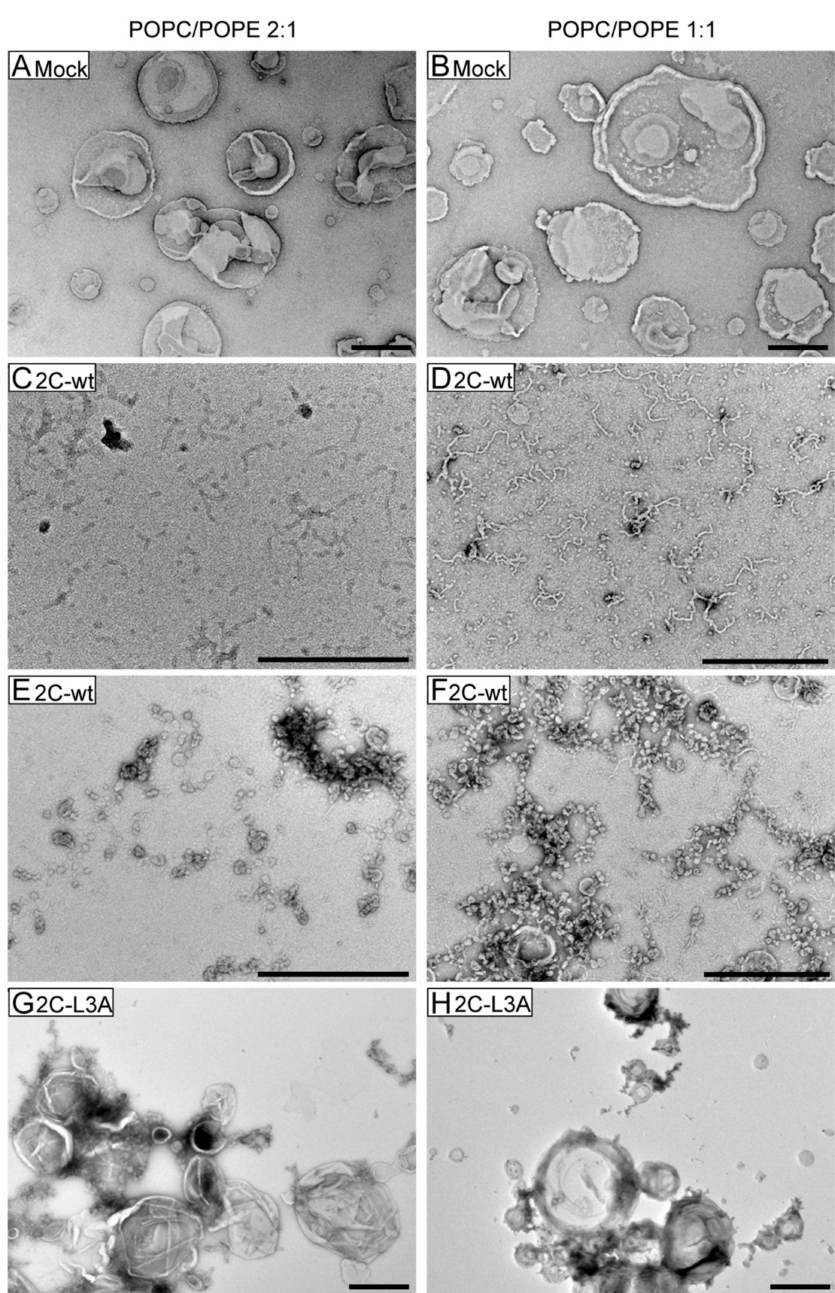
Figure 6. 2C-wt but not 2C-L3A remodels vesicles with physiologically relevant lipid compositions. Peptide 2C-wt or 2C-L3A (100 µ M) was incubated with 500 µ M of POPC / POPE 2:1 (left column) or POPC / POPE 1:1 (right column) vesicles. Lipid vesicles of POPC / POPE 2:1 ( A ) or POPC / POPE 1:1 ( B ) in the absence of peptides. Small tubes ( C , D ) or small vesicular structures ( E , F ) were formed when POPC / POPE 2:1 ( C , E ) or POPC / POPE 1:1 ( D , F ) vesicles were incubated with 2C-wt. No structural changes were observed for POPC / POPE 2:1 ( G ) or POPC / POPE 1:1 ( H ) vesicles in the presence of 2C-L3A. Scale bar = 500